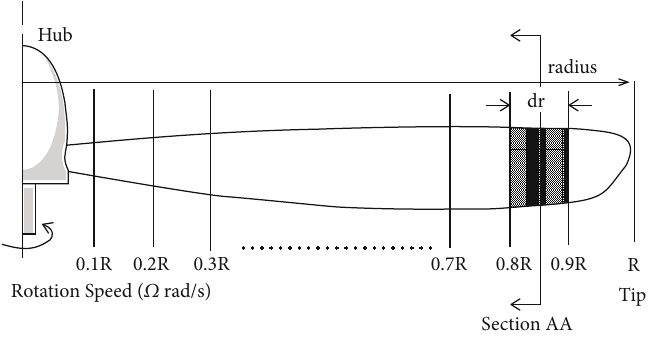
Figure 6: Blade element subdivision [23].